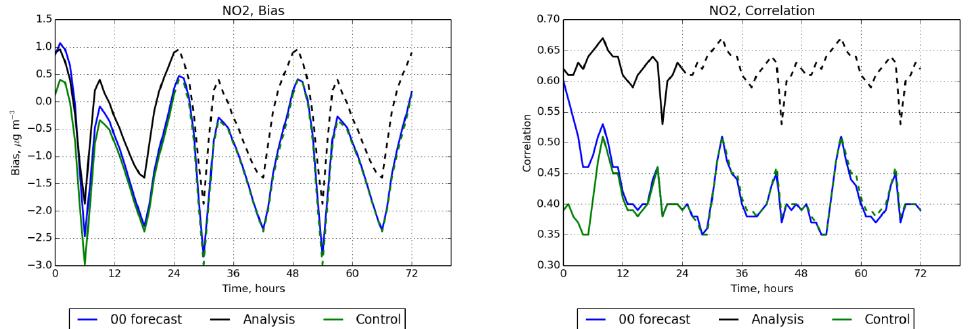
Figure 8. As Fig. 7, but for NO 2